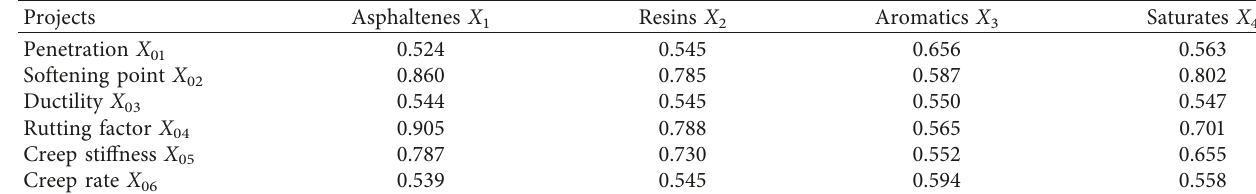
Table 5: Relationship degrees between the properties indices and four components.